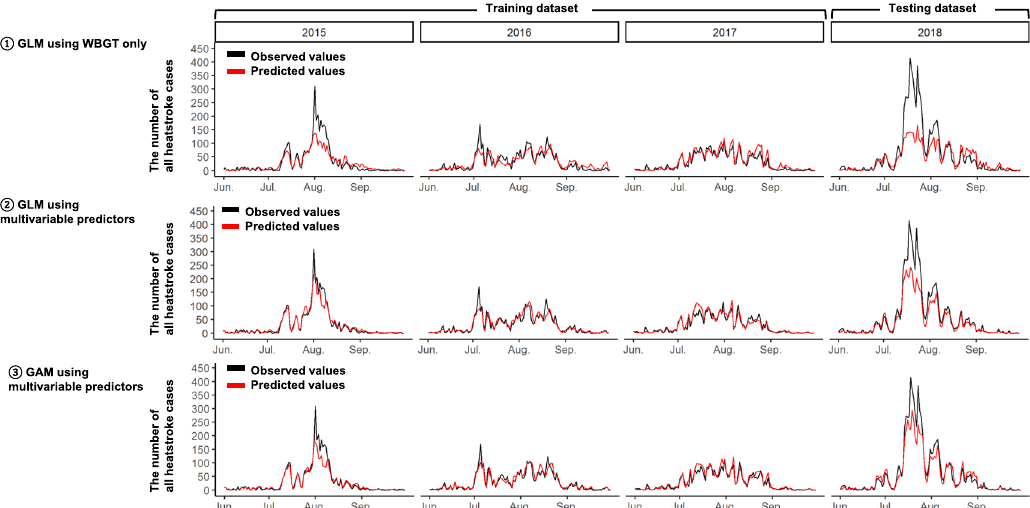
Fig. 1 Comparison between observed and predicted numbers of all heatstroke cases from June to September in 2015, 2016, and 2017 (i.e., training dataset), and 2018 (i.e., testing dataset) by GLMs and GAM. The black lines indicate the observed total number of heatstroke per day in the 16 Japanese cities, and the red lines indicate the predicted total number of heatstroke per day in the 16 Japanese cities obtained from the following prediction models: (1) GLM using WBGT as the only predictor, (2) GLM using multivariable predictors, and (3) GAM using multivariable predictors. GLM generalized linear model, GAM generalized additive model, WBGT wet bulb globe temperature.